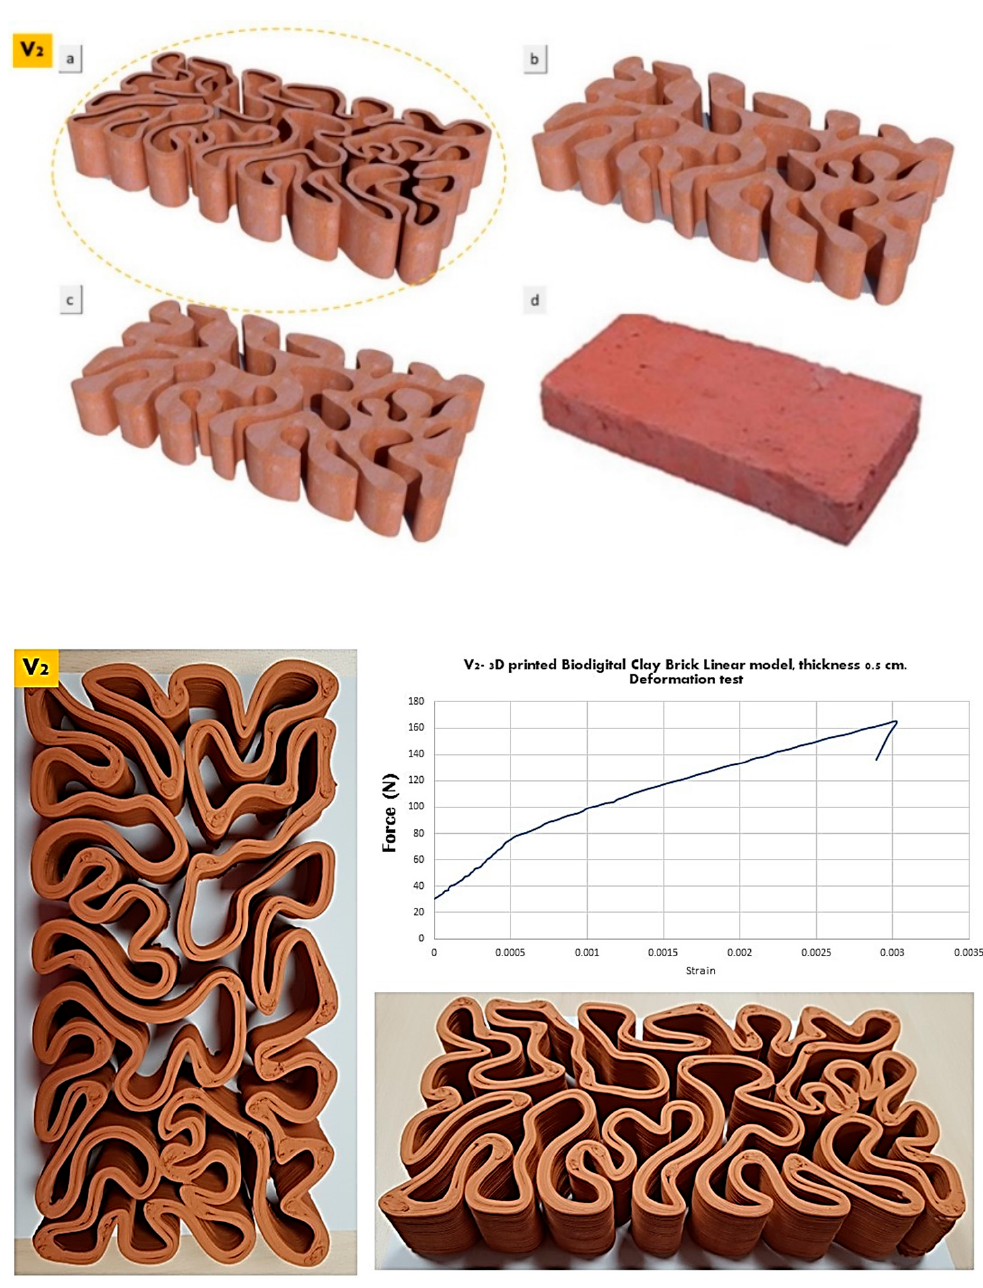
Figure 7. Exhibits the linear brick model of the V2 family of the biodigital clay bricks with double line linear thickness of 0.5 cm in 3D renders ( top ) as ( a ) is the tested linear brick model while ( b – d ) are the bulk models of the same family with variant densities. and in physical 3D-printed model ( bottom ). The graph exhibits the results of the deformation test for this brick, showing the relation between force (N) ( Y -axis) and strain ( X -axis). The V2 linear model biodigital brick exhibited its highest strain (pre-cracking) of 0.003 under 160 N, with continuously decreased elasticity